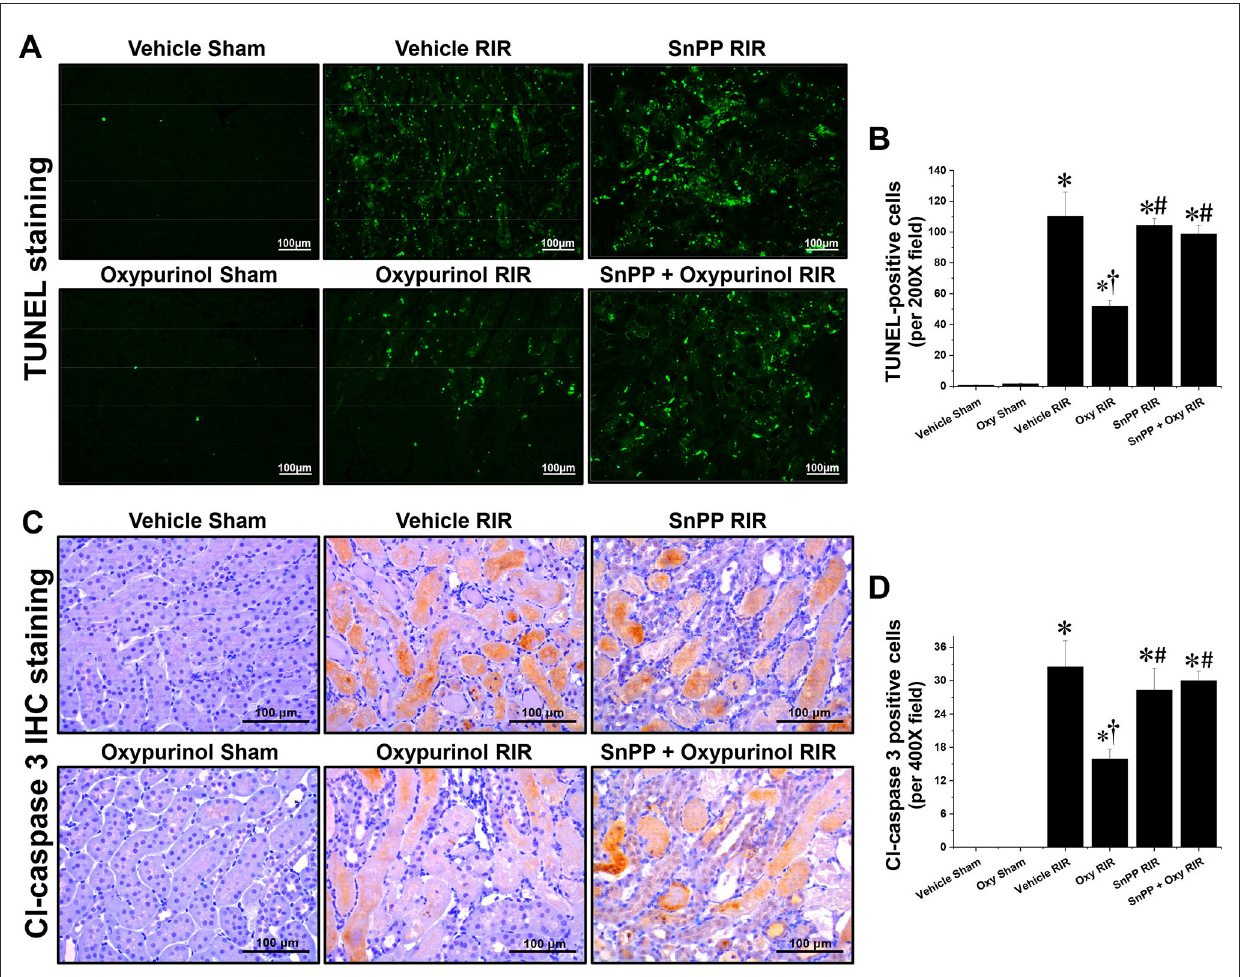
FIGURE2 Oxypurinol protects renal tubular apoptotic cell death after renal ischemia/reperfusion injury. C57BL/6 male mice were subjected to sham or 30min of renal ischemia surgeries. Some mice were pretreated with 25 mg/kg of oxypurinol 24h and 1h before surgeries. Separate cohorts of mice were injected with tin protoporphyrin IX [SnPP, a heme oxygenase-1 (HO-1) inhibitor, 25 mg/kg, Tocris Bioscience] 30min before oxypurinol first treatment. (A) Representative images (magnification, 200 × ) of post-operative TUNEL staining in the kidneys are shown, and (B) the TUNEL-positive cells were counted. (C) Representative images (magnification, 400 × ) of immunohistochemistry staining using anti-cleaved-caspase 3 (Cl-caspase 3) antibody, and (D) the Cl-caspase 3-positive cells were counted. Results are expressed as means ± SEM (vehicle or oxypurinol [oxy] sham n =